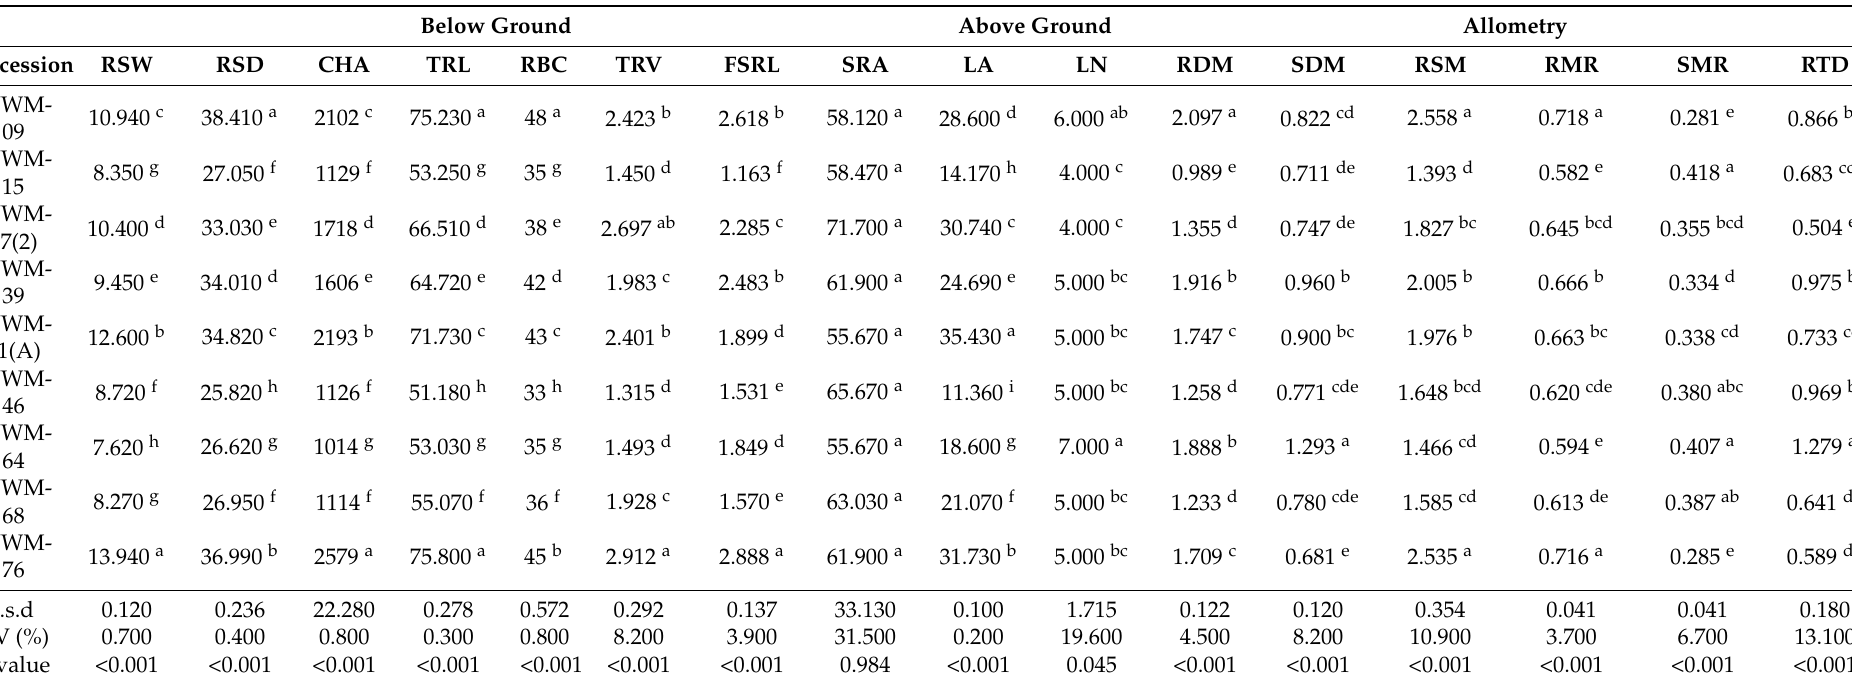
Table 3. Mean values for root and leaf traits of nine citron watermelon accessions evaluated in rhizotrons under water-stress conditions 35 days after planting. Below Ground Above Ground